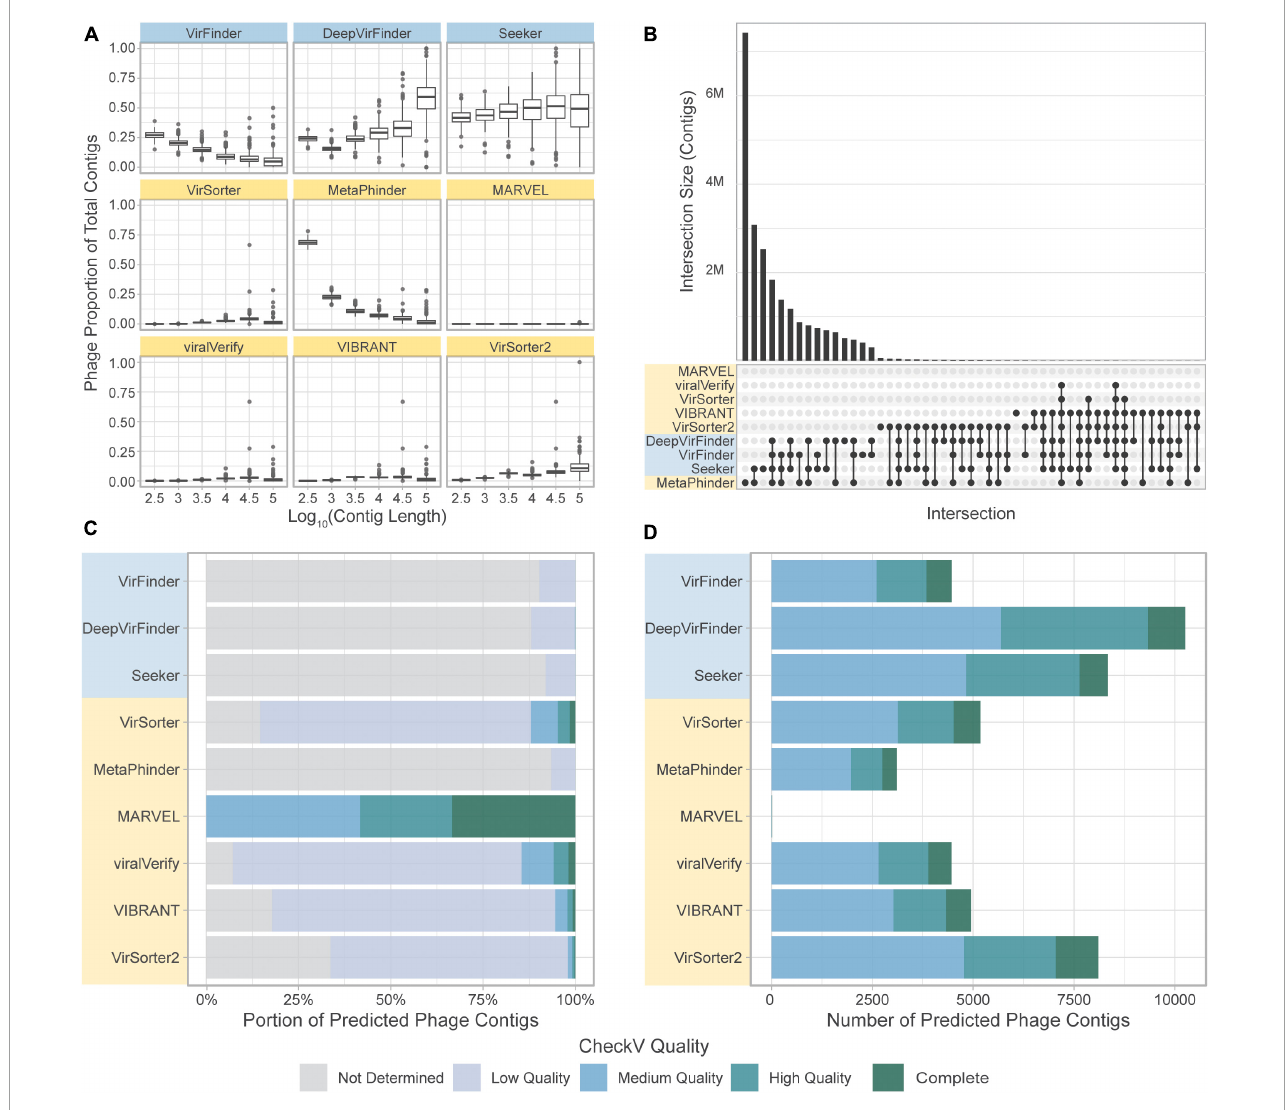
FIGURE8 Comparison of the tools’ classifications on a real-world metagenomic dataset. (A) Proportion of contigs predicted to be phage in each length group for each sample. (B) Upset plot showing intersection size, with the x -axis in order of decreasing set size, top 51 intersections shown. (C) CheckV assessment of predicted phage contigs from the CRC dataset . Predicted phage contigs from each tool are categorized by CheckV, and plotted as a stacked bar chart of the portion of predicted phages in each category. (D) Total number of contigs predicted by CheckV to have quality Medium or greater. Sequence-based tools are in blue, homology-based tools are in